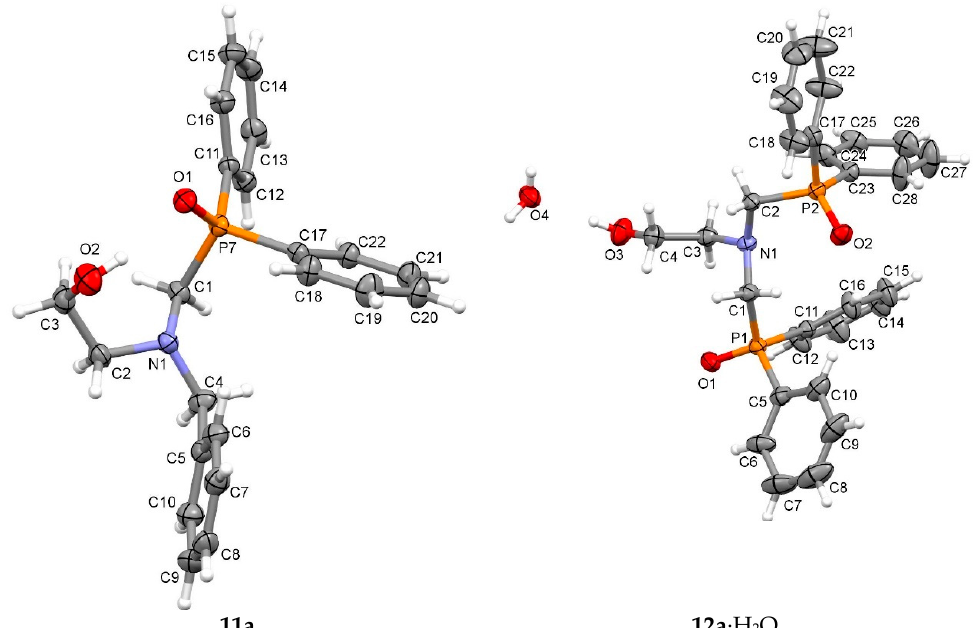
Figure 1. X-ray structures and atom numbering of compounds 11a and 12a · H 2 O. Probability ellipsoids are drawn at the 30% level.